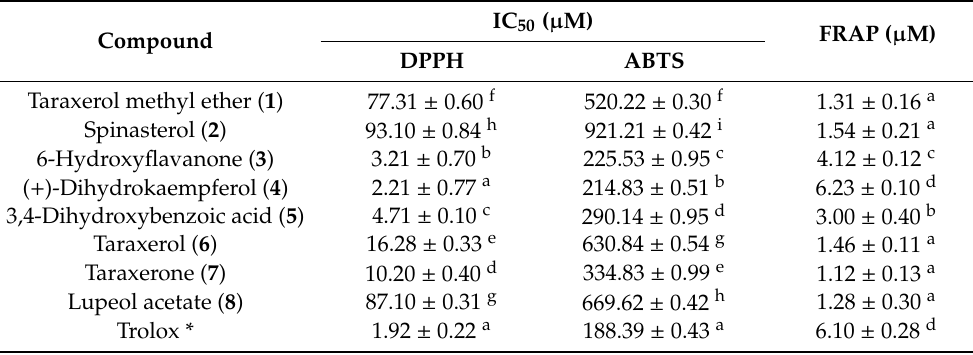
Table 3. Antioxidant activities of compounds 1 – 8